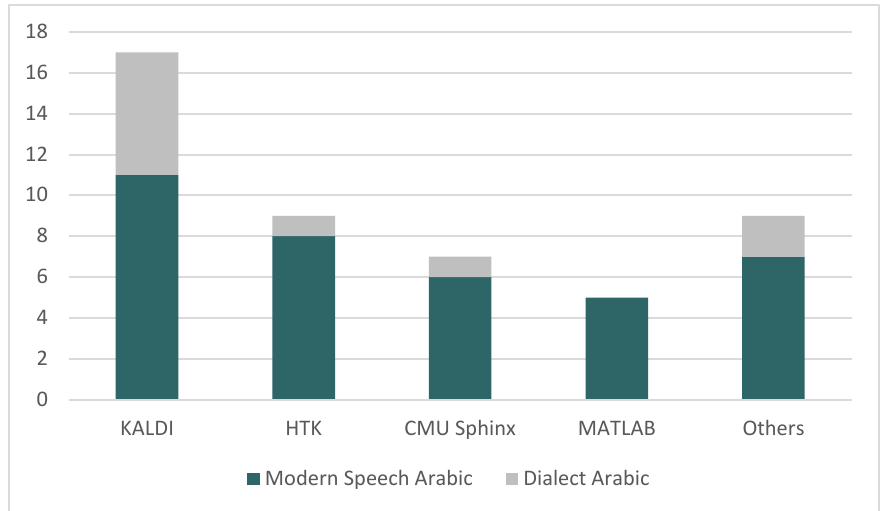
Figure 4. Frequency of use of toolkits according to the used type of Arabic. Some studies were based on more than one toolkit. Then, the same study was repeated, which increased the total number of studies.